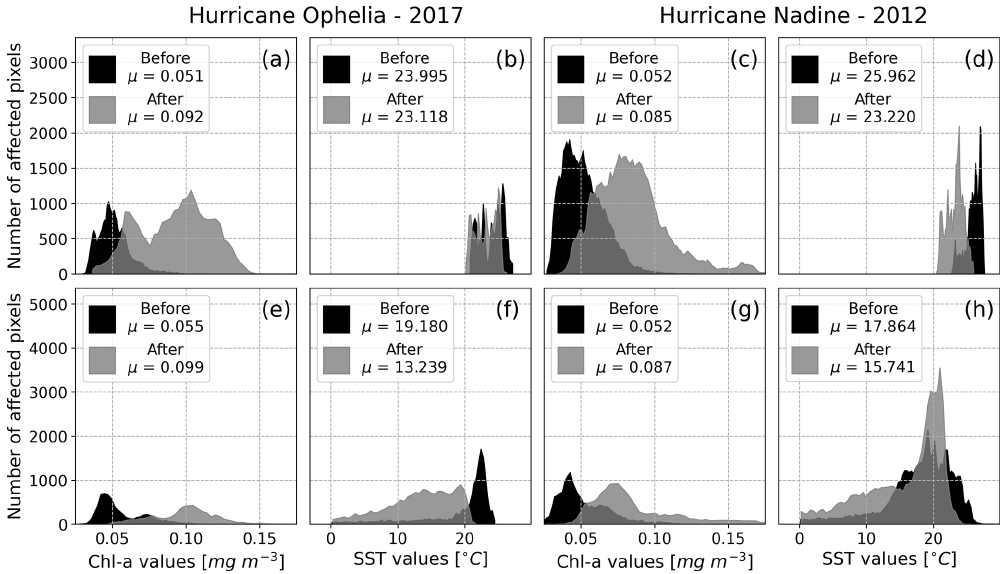
Figure 8. Comparison between interpolated “cloud-free” data (a–d) and non-interpolated data (e–h) for Hurricanes Ophelia (2017) and Nadine (2012). Values for non-interpolated data were obtained with the same methodology as the ones presented before and represent the exact same days of analysis. Mean values for each histogram are presented, with black histograms representing the situation before the TC and the grey ones the situation